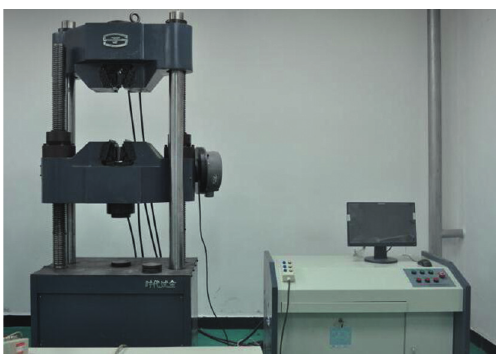
Figure 2: WAW-600C mechanical test